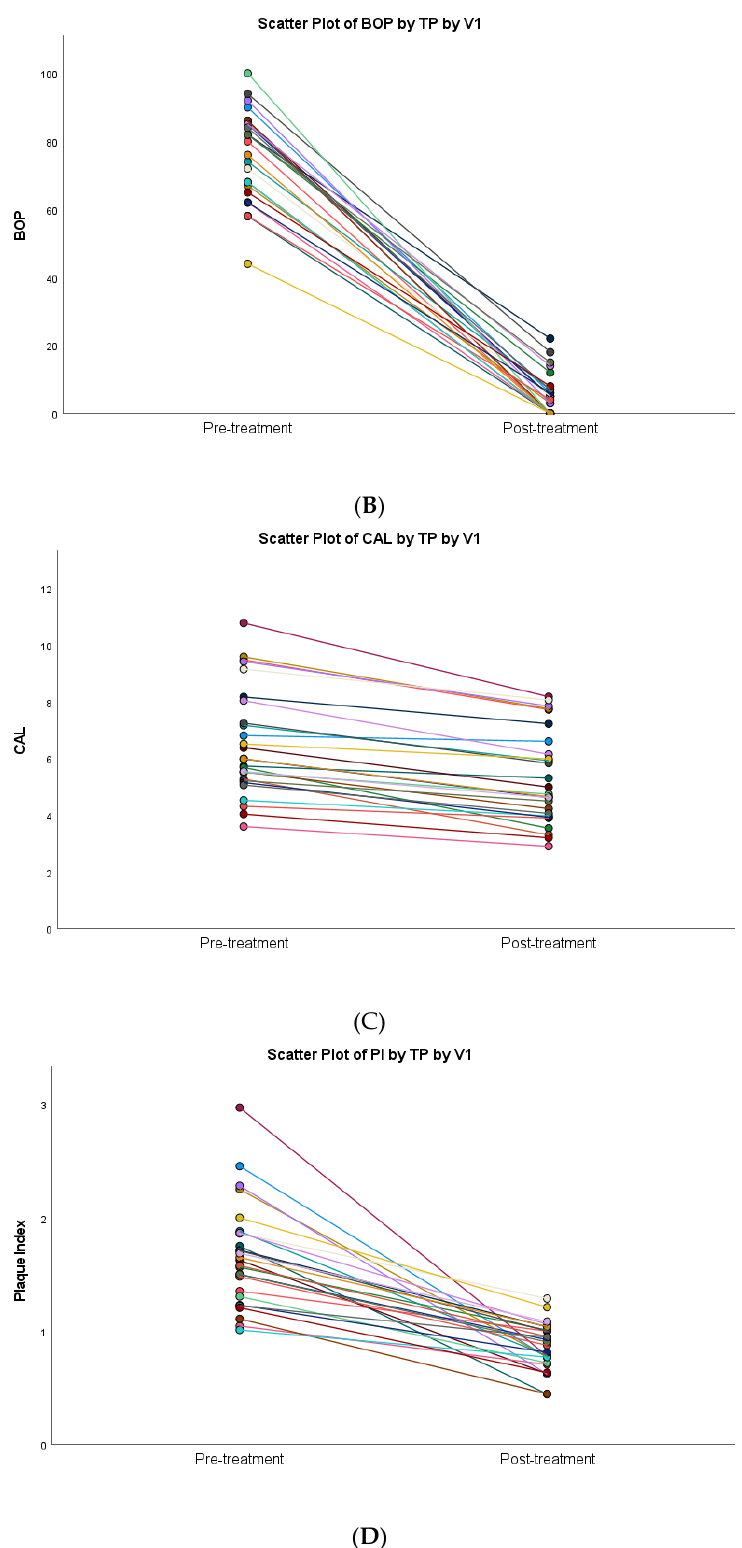
Figure 2. Differences in periodontal clinical parameters at baseline and 1 month after anti-infective periodontal treatment. The linear regression line is shown in different colors for each subject: ( A ) PD = probing depth; ( B ) BOP = bleeding on probing; ( C ) CAL = clinical attachment level; ( D ) PI = plaque